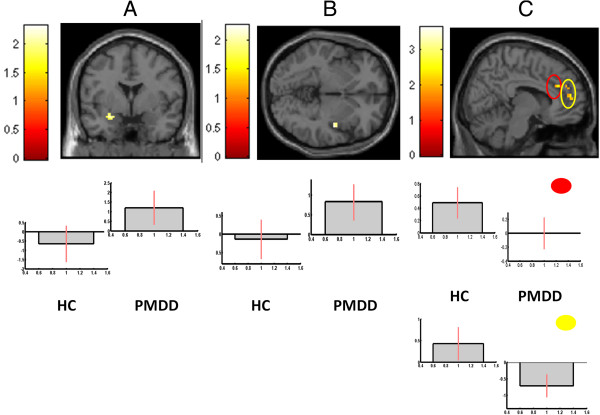
BOLD reactivity. Patients with PMDD had enhanced reactivity to socially relevant stimuli as compared to non-social stimuli in two regions of interest, the (A) left amygdala (−21, 2, −15; k = 11; z = 2.18; P = 0.015) and (B) the right insula (45, −9, −2, k = 10, z = 2.13, p = 0.016) when compared to healthy controls in the luteal phase. (C) Women with PMDD also had attenuated reactivity to social stimuli in the midline ACC in two clusters marked in red and yellow respectively (9, 33, 23; k = 12; z = 2.22; p = 0.013; and 3, 50, 11; k = 27; z = 3.23; p = 0.001). All anatomic localizations are given in Talairach coordinates. Brighter colors represent higher t scores. Below the brain images, contrast estimate plots are given for the peak voxel of each cluster. Healthy controls are given in the left panels and PMDD to the right. ACC, anterior cingulate cortex; PMDD, premenstrual dysphoric disorder.